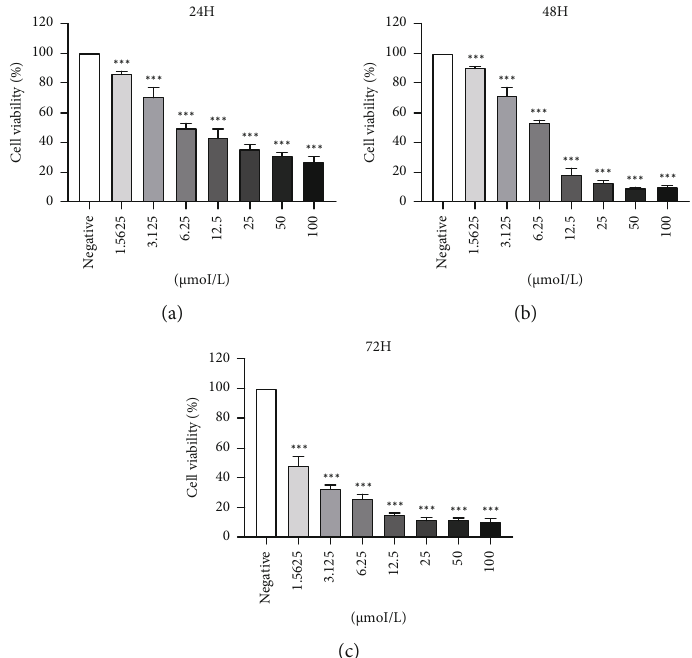
Figure 1: Anlotinib inhibits HSC-3 cell growth. MTT assay tested the cell proliferation was determined. Di ff erent doses of anlotinib (0, 1.5625, 3.125, 6.25, 12.5, 25, 50, and 100 μ M) inhibited the proliferation of HSC-3 cells after 72 h of treatment. The data are expressed as the mean ± S : E : M : , n = 3 with available di ff erences from the control designated by ∗∗∗ P < 0 : 001 : (a) 24h; (b) 48h; (c) 72 h.